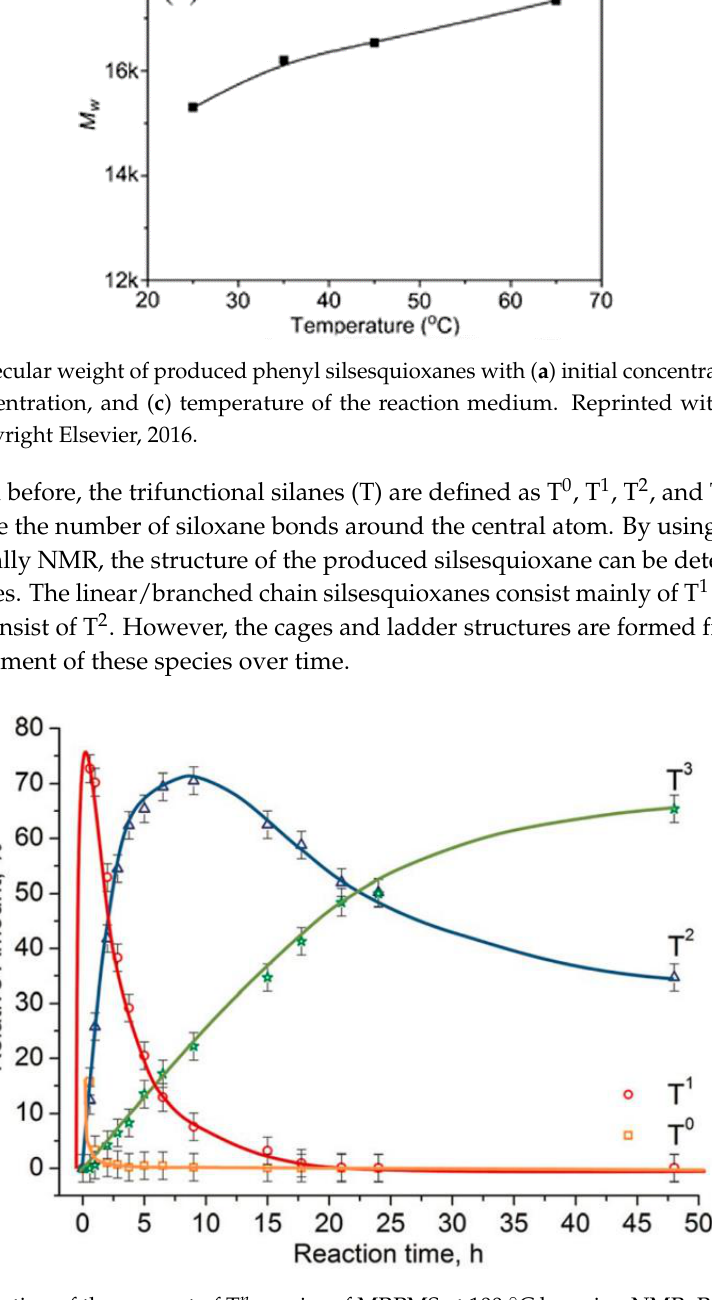
Figure 21. Evolution of the amount of T n species of MRPMS at 100 ◦ C by using NMR. Reprinted with permission from [24]. Copyright John Wiley and Sons, 2016.